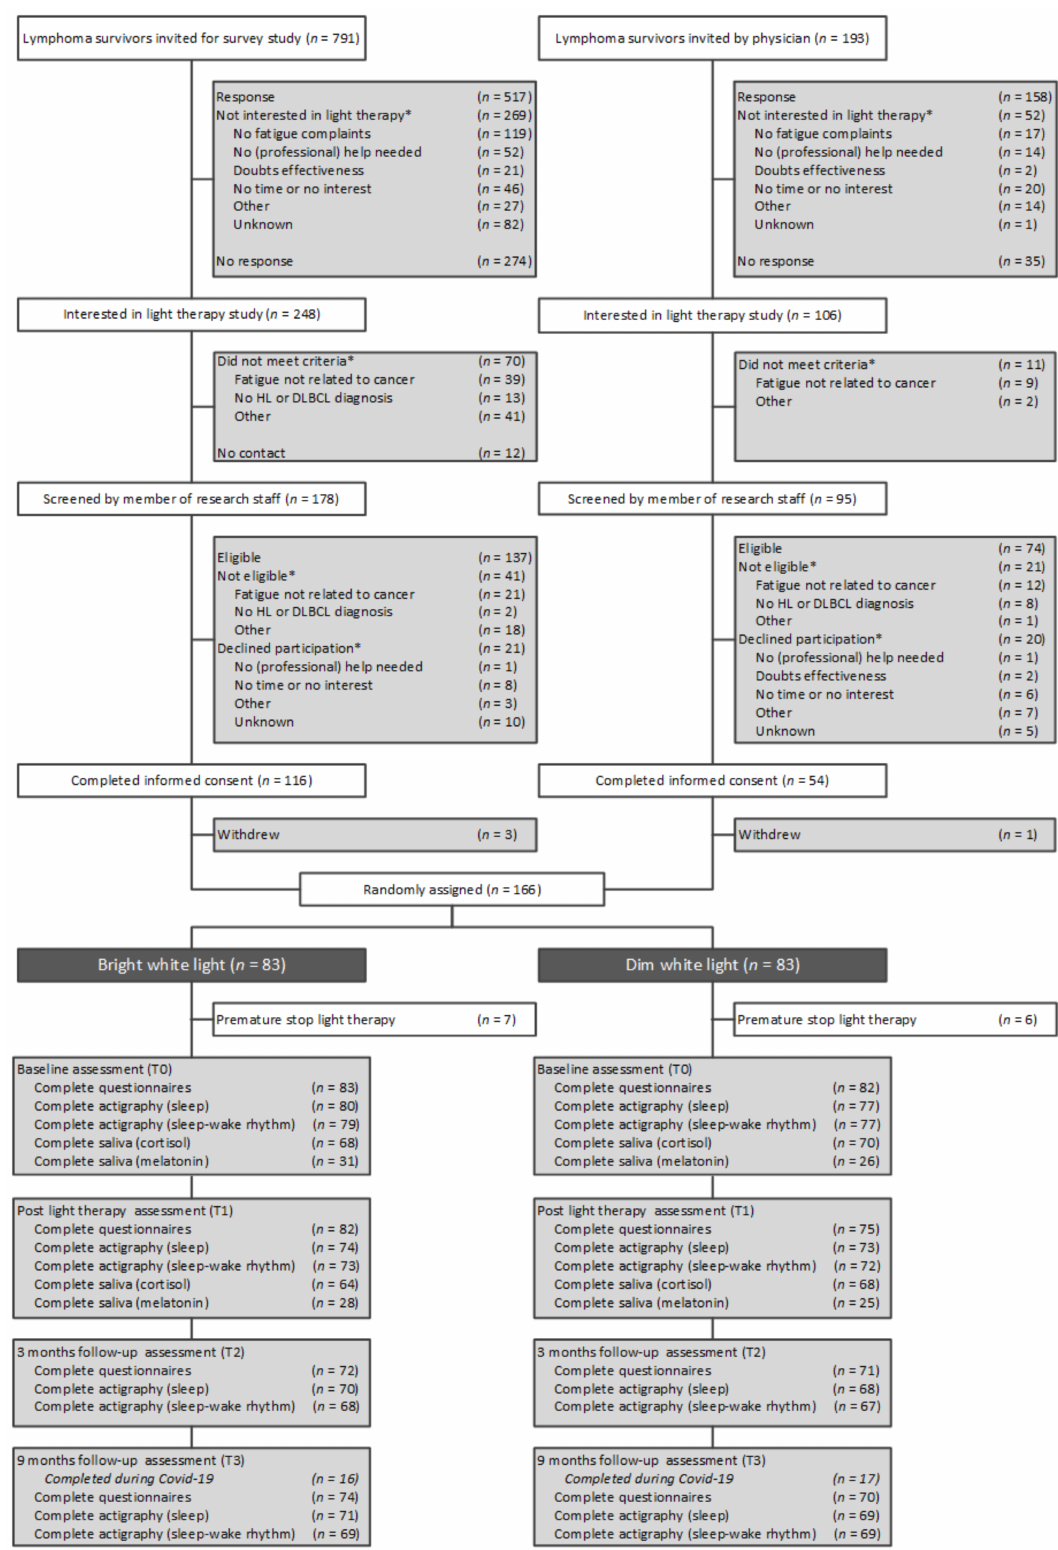
Figure 1. CONSORT diagram. Abbreviations: HL, Hodgkin lymphoma; DLBCL, diffuse large B-cell lymphoma. Note: Number of missing assessments at T1, T2, and T3 were not necessarily cumulative. * Patients could provide more than one reason for non-participation or could be excluded for more than one